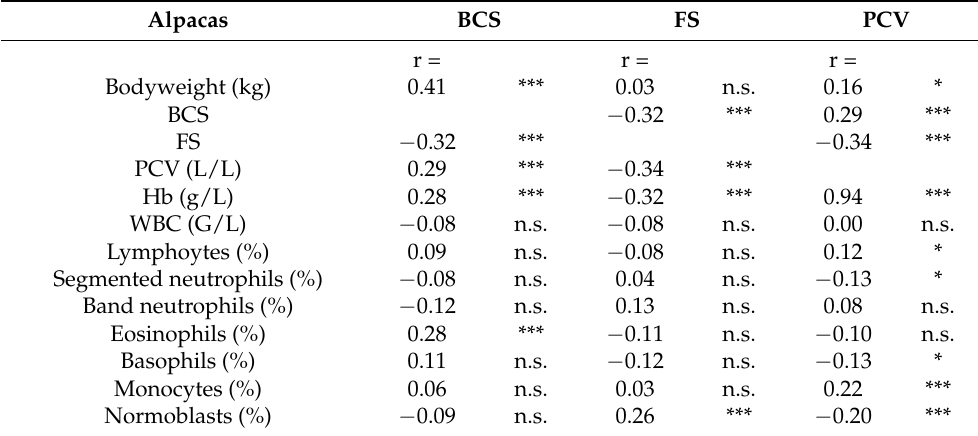
Table 2. Results of Spearman’s correlation for BCS, FS, and PCV with the investigated clinical and haematological parameters in alpacas (n = 259). * = p < 0.05; *** = p < 0.001; n.s. = not significant.